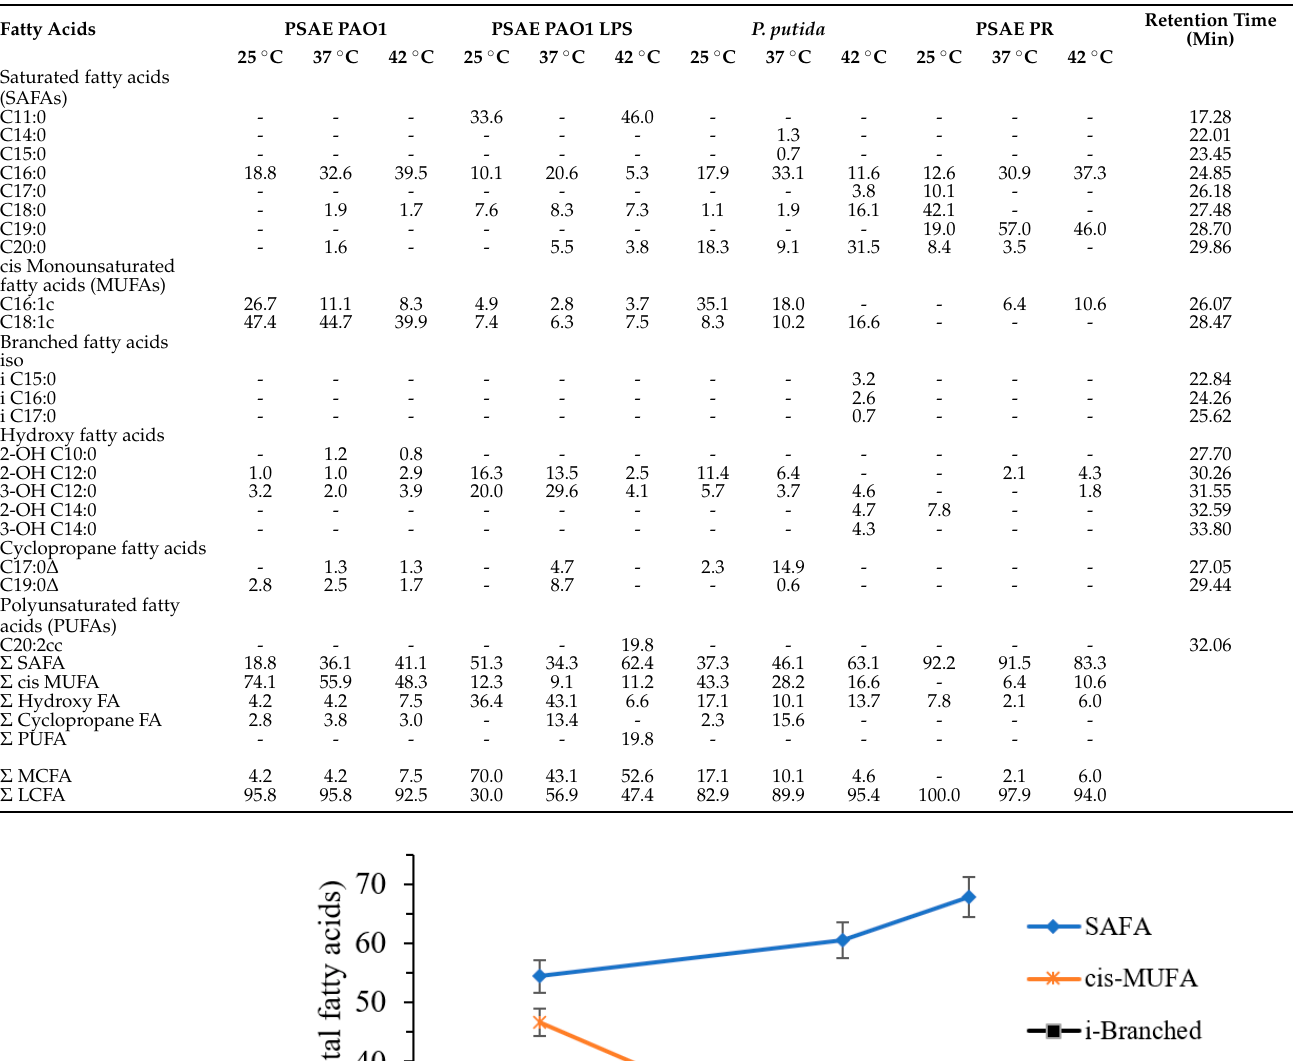
Table 3. Fatty acid methyl ester presence in samples from P. aeruginosa PAO1, P. aeruginosa ATCC 27853, P. putida , and P. aeruginosa polyresistant bacteria based on the percentile peak area. The bacteria were cultivated at 25 ◦ C, 37 ◦ C and 42 ◦ C on agar media. Fatty acids were extracted one day following inoculation. The relative standard deviation is less than 2%. Experiments are made in triplicates.